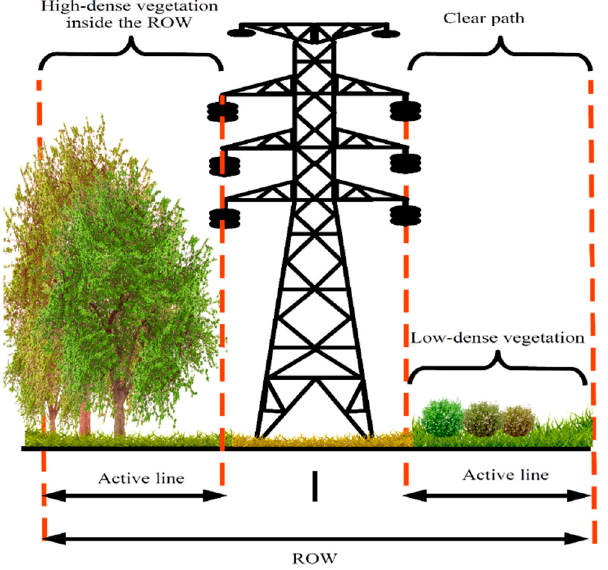
Figure 1. Low- and high-density vegetation encroachment on the power line corridor right-of-way